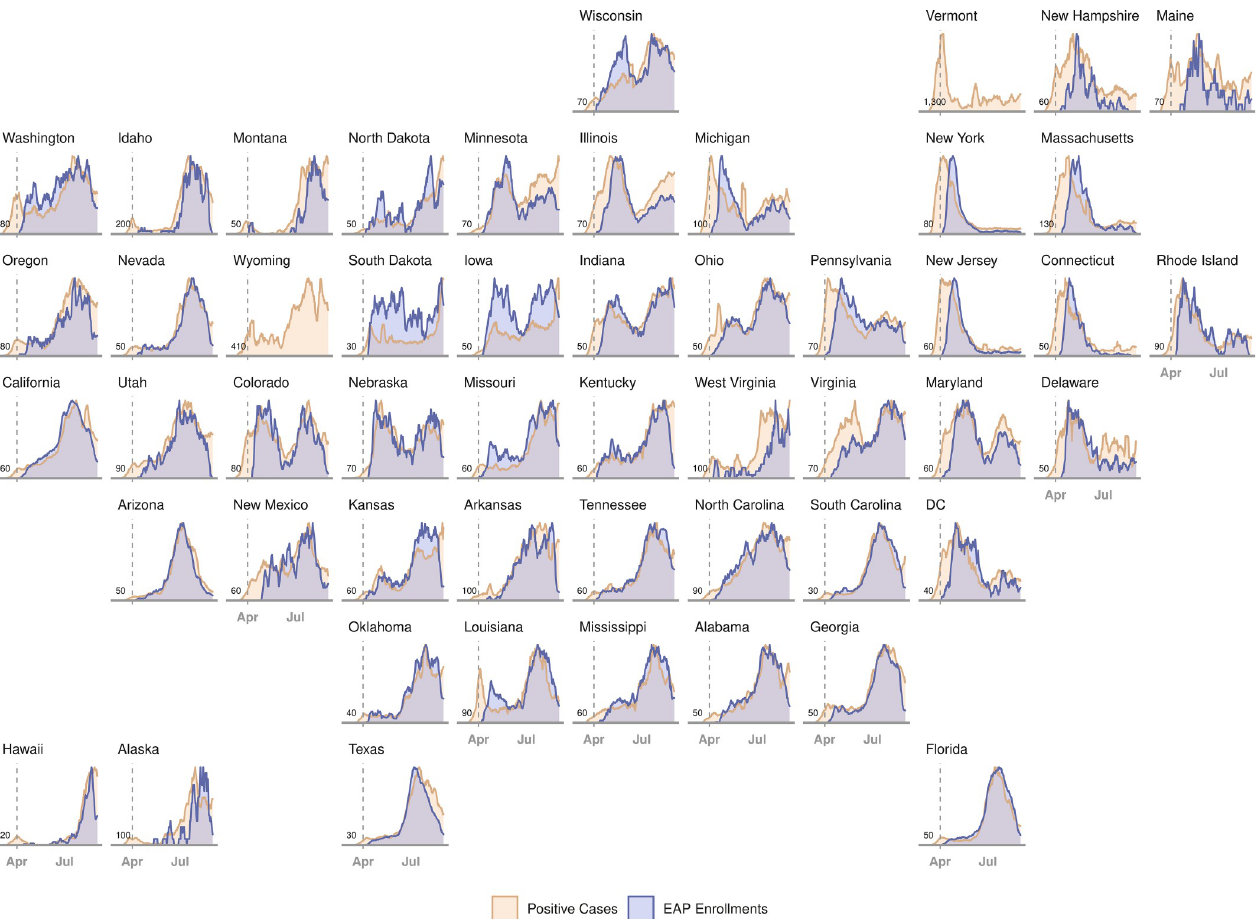
Fig 5. Daily rates of confirmed COVID-19 infections and patient enrollment in the US Expanded Access Program (EAP). Chronological line charts represent the daily number of statewide confirmed COVID-19 infections and EAP patient enrollments sequentially arranged in a geofaceted depiction of the US. Daily rates are presented as a moving average across 7 days, scaled between 0 (least cases/enrollments) and 1 (most cases/enrollments) for any day in each state. Vertical dashed grey lines represent the start date of the EAP (April 3, 2020). Values in the lower left corner of each panel indicate the scaling factor between the 2 plots (cases/enrollments), which approximates the number of COVID-19 cases that contributed to 1 enrollment in the EAP. EAP enrollment data are not presented for Vermont or Wyoming because total enrollments were not greater than 10 patients. DC, District of Columbia.